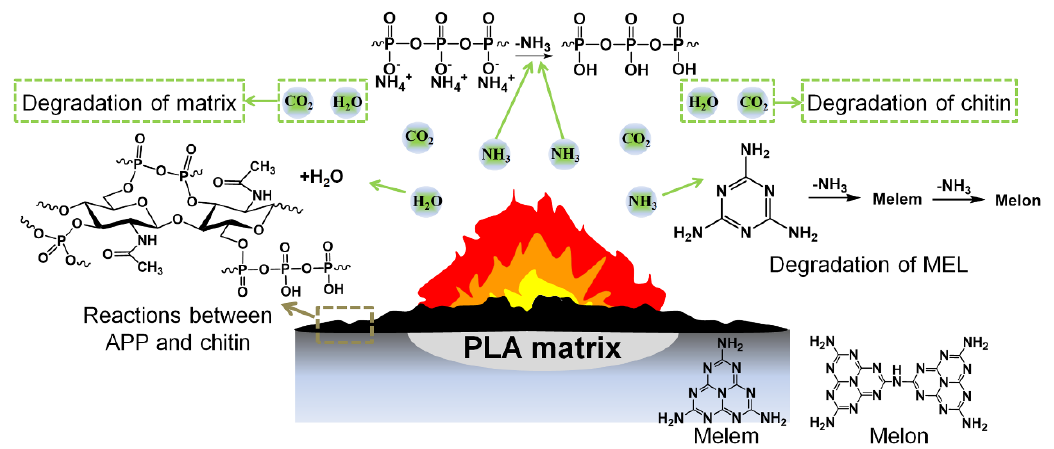
Figure 9. The proposed flame-retardant mechanism of PLA/chitin-based IFR composites.